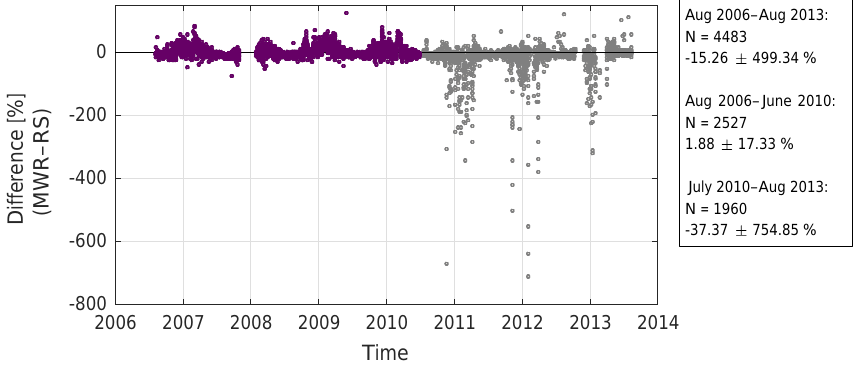
Figure 15. Comparisons between the MWR and radiosondes. Data used in this study are in purple; data that are available but not used due to calibration and quality concerns are in grey. The change in agreement from fall 2010 onwards is clearly evident. The plot scale cuts off extreme